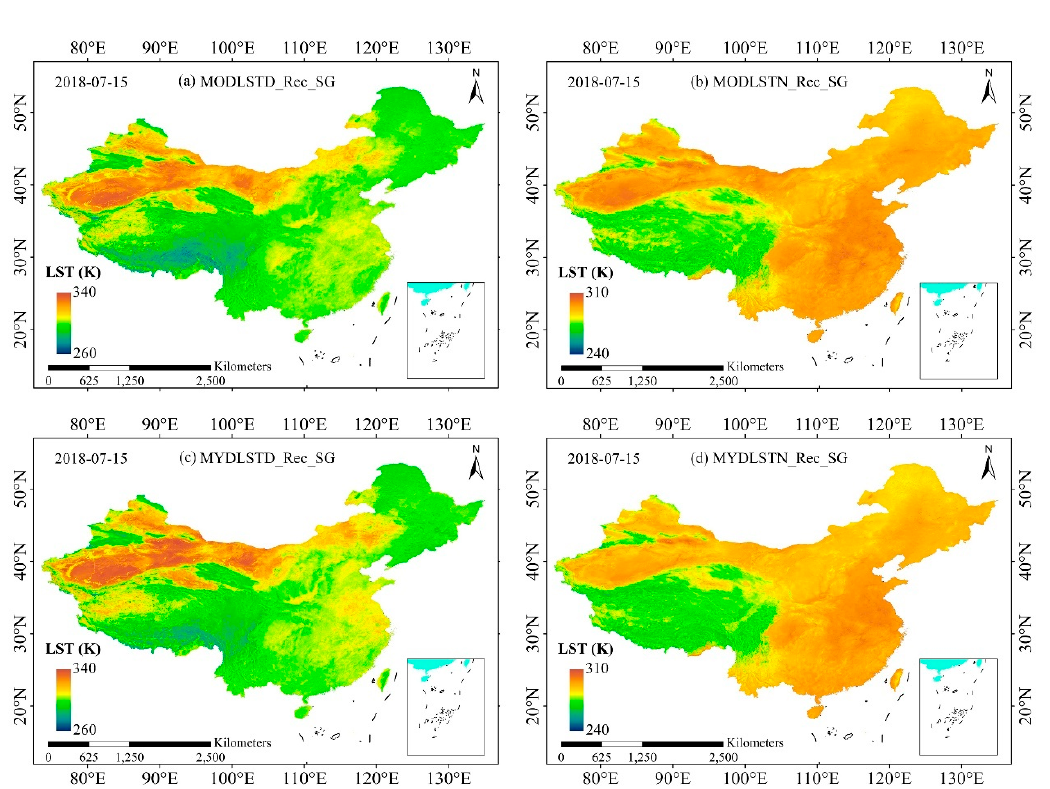
Figure A2. Reconstructed MODIS LST results on 15 July 2018.